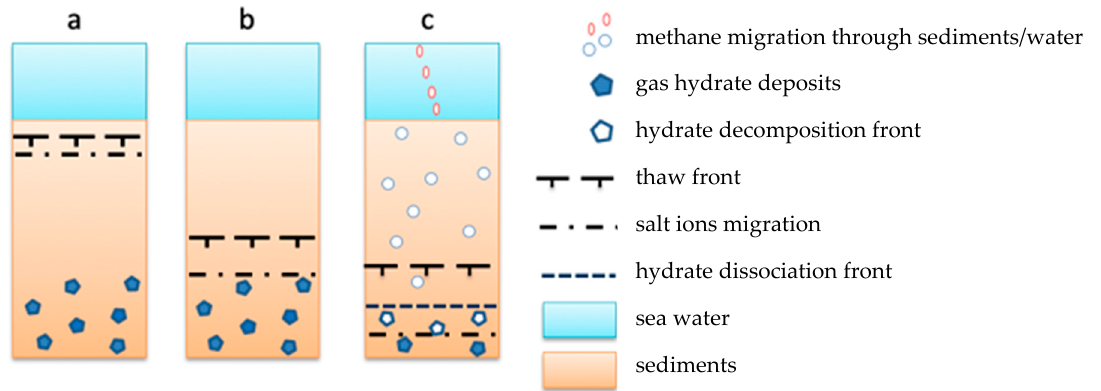
Figure 11. An estimated model of the interaction of cooled sea water with frozen sediments containing relict gas hydrates. ( a ) Initial state (interaction between cold seawater and frozen sediments); ( b ) Penetration of sea salt into permafrost (formation of salinity and thawing fronts); ( c ) Interaction of salt front with intra-permafrost gas hydrate accumulations (decomposition of gas hydrates, active methane emissions).